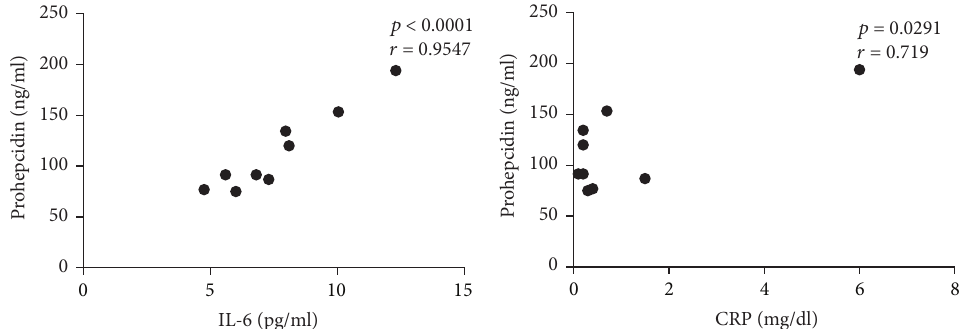
Figure8: Correlation between IL-6and CRPversusprohepcidin inUCpatients. Statistical analysiswas performed usingPearson’s correlation